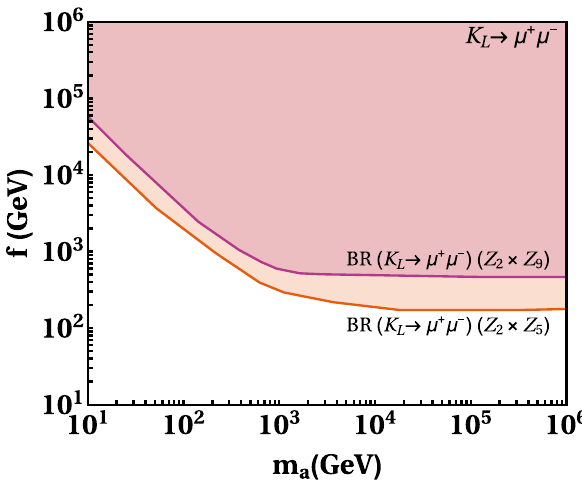
Fig. 9 The parameter space allowed by BR ( K L → μ + μ − ) SD with λ χ = 2 in the m − f plane for the minimal ( Z a minimal ( Z 2 × Z 9 ) model are shown with red and magenta coloured boundaries,